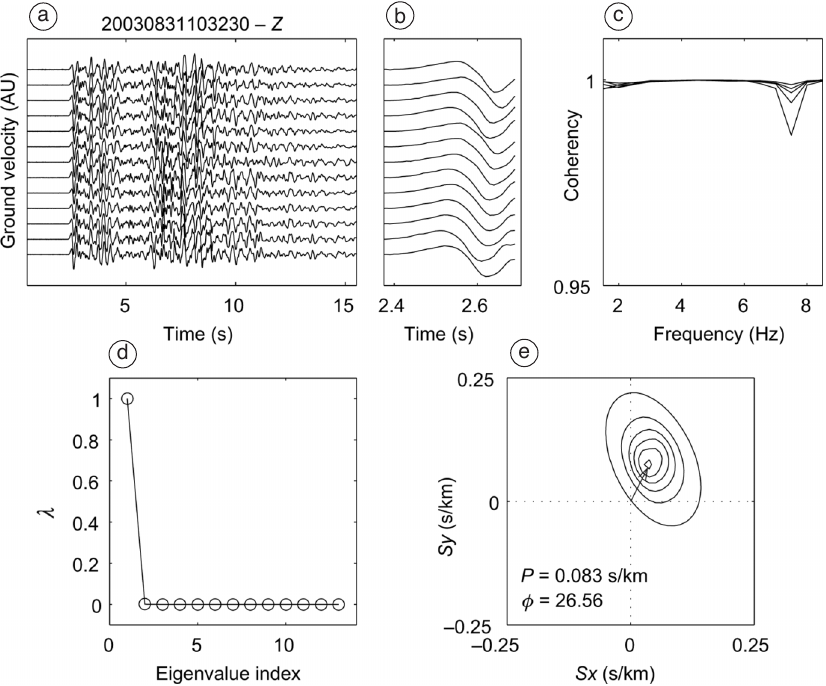
Fig. 7a-e. a) Vertical-component seismograms for an event occurred at 10:32:30 GMT on August 31, 2003. b) Time interval used for P -wave slowness analysis. c) Multichannel signal Coherency (eq. (3.2) in text) over the frequency band selected for the analysis. The different lines refer to the five consecutive time position of the win- dow of analysis. d) The ordered set of normalized eigenvalues derived from diagonalization of the spatial co- variance matrix. e) Time-Frequency stacked slowness spectrum. Propagation azimuth φ and ray parameter ⎢ P ⎪ associated with the peak value are reported at the bottom left of the plot. The arrow points to the direction of wave